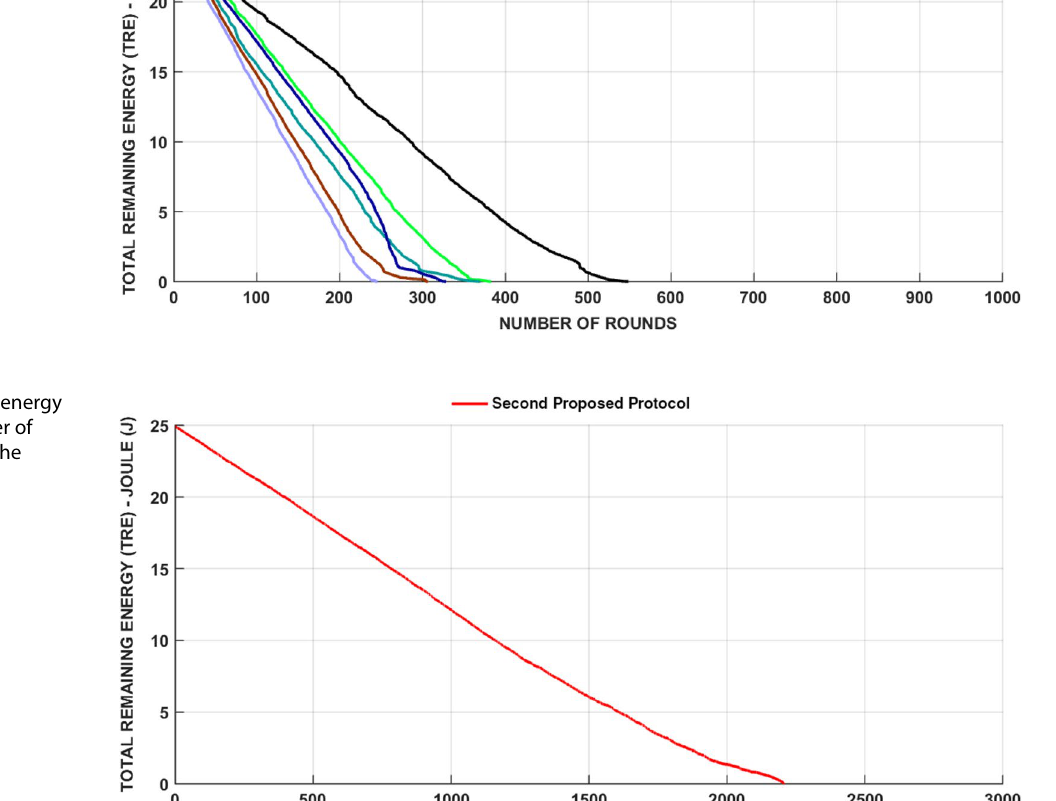
Fig. 19 Total remaining energy in relation to the number of rounds in scenario 4